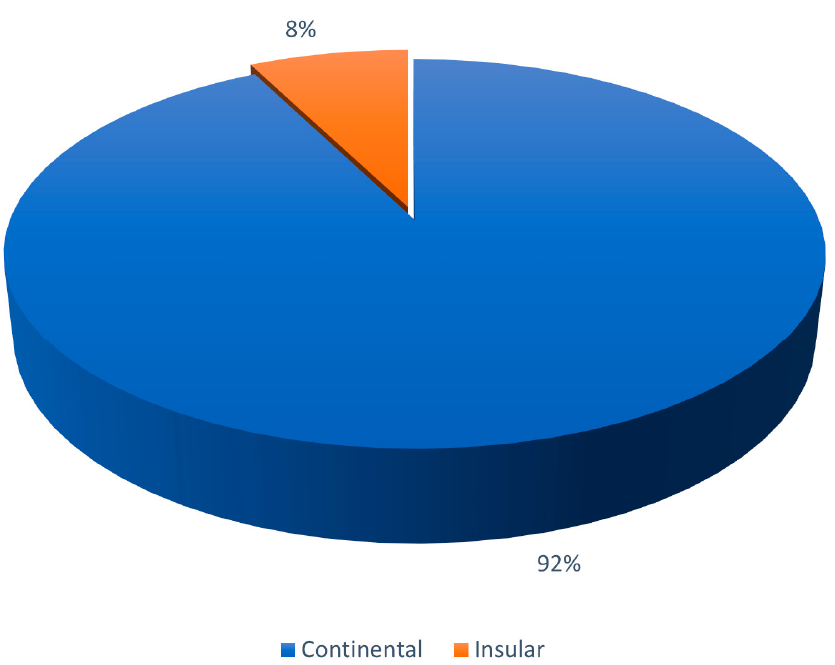
Figure 4. Percentage of all “Extreme rainfall events” articles of Mediterranean bioregion.